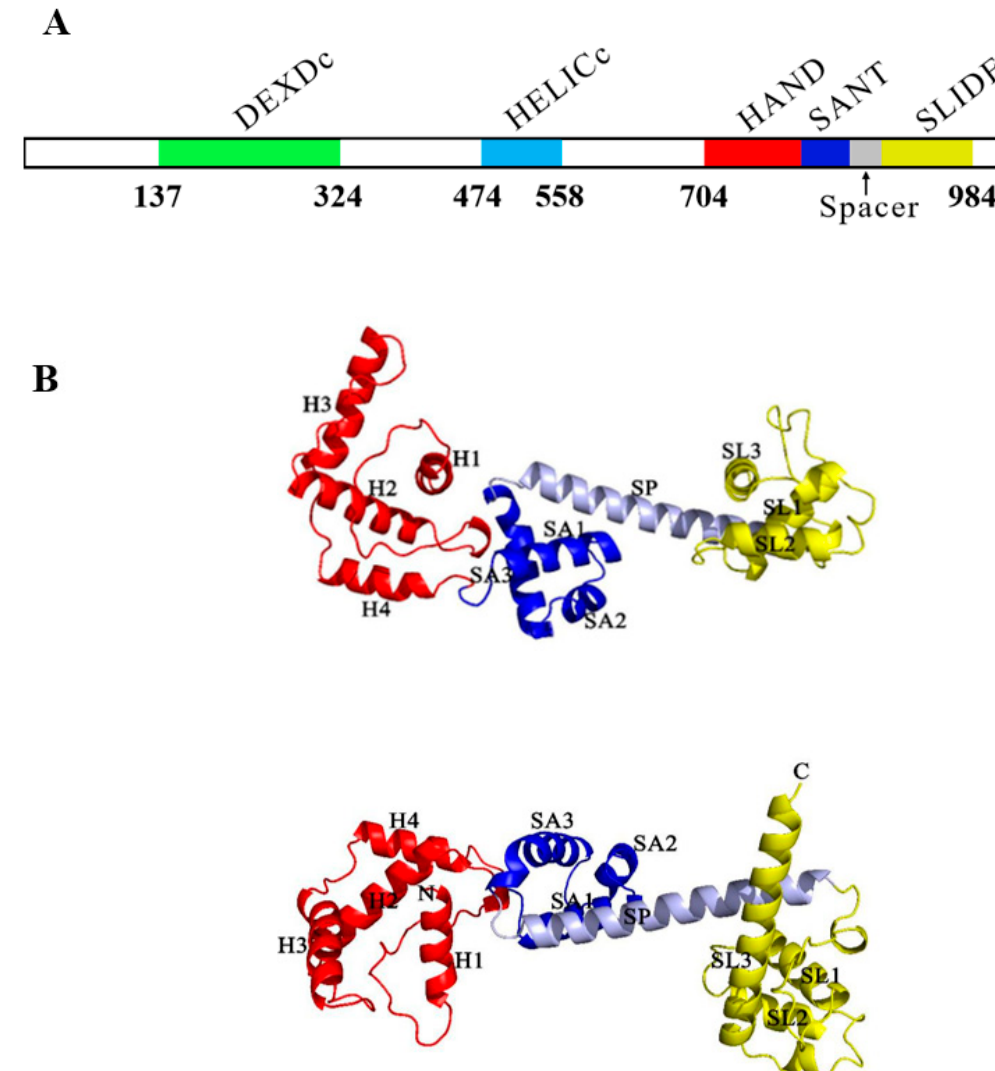
Figure 2. Functional domains in Bemisia tabaci MEAM1 BtISWI protein ( A ) and two orthogonal views of the predicted BtISWI C-terminal structure ( B ). The DEXDc domain is depicted in green, HELICc domain in baby blue, HAND domain in red, SANT (SWI3, ADA2, N-CoR, TFIIIB) domain in blue, SLIDE (SANT-like ISWI) domain in yellow, and the spacer helix connecting the SANT and SLIDE domains in gray.